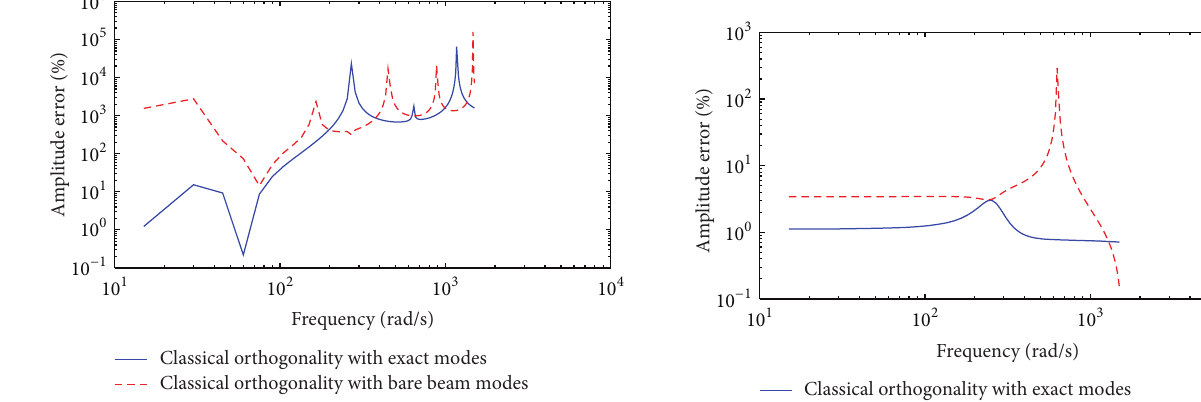
Figure 8: Frequency response amplitude error of a guided-guided beam carrying one in-span mass-spring-damper-mass system for = 0.1 kg, 𝑀 = 0.05 kg, 𝑇 = 360 N, 𝐸𝐼 = 𝑘 = 10 N/m, 𝑀 𝑑 𝑐 = 0.1 Ns/m, and 𝐿 = 0.1 m. 36.458 Nm 2 , 𝑐 𝑑 𝑑